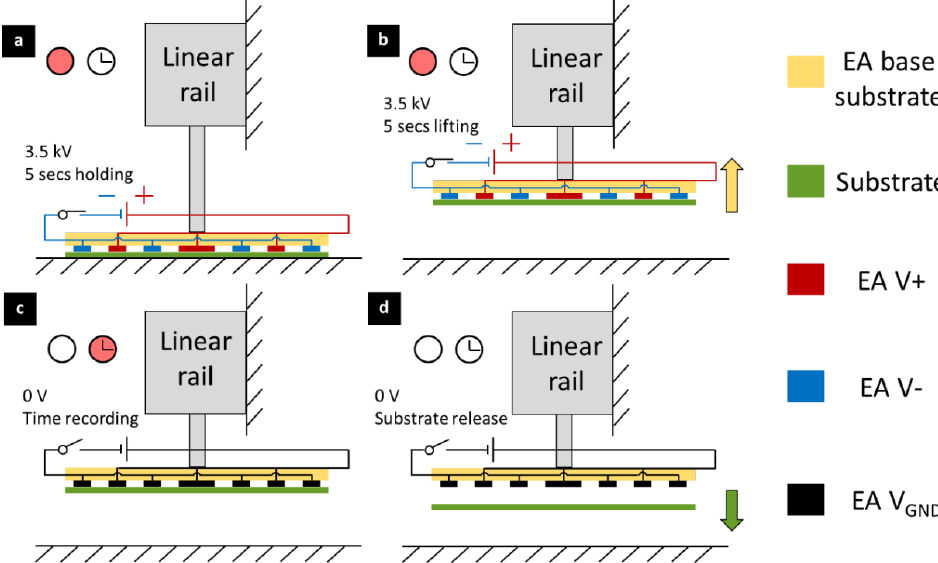
Figure 3. Schematic diagrams of experimental procedure; an exposed-electrode EA pad was mounted on a linear rail; ( a ) the EA pad approached to a substrate and a 3.5 kV voltage was applied, holding for 5 s; ( b ) the EA pad was lifted; ( c ) voltage was removed and the release timing began; ( d ) the substrate released from the EA pad and release time is measured.